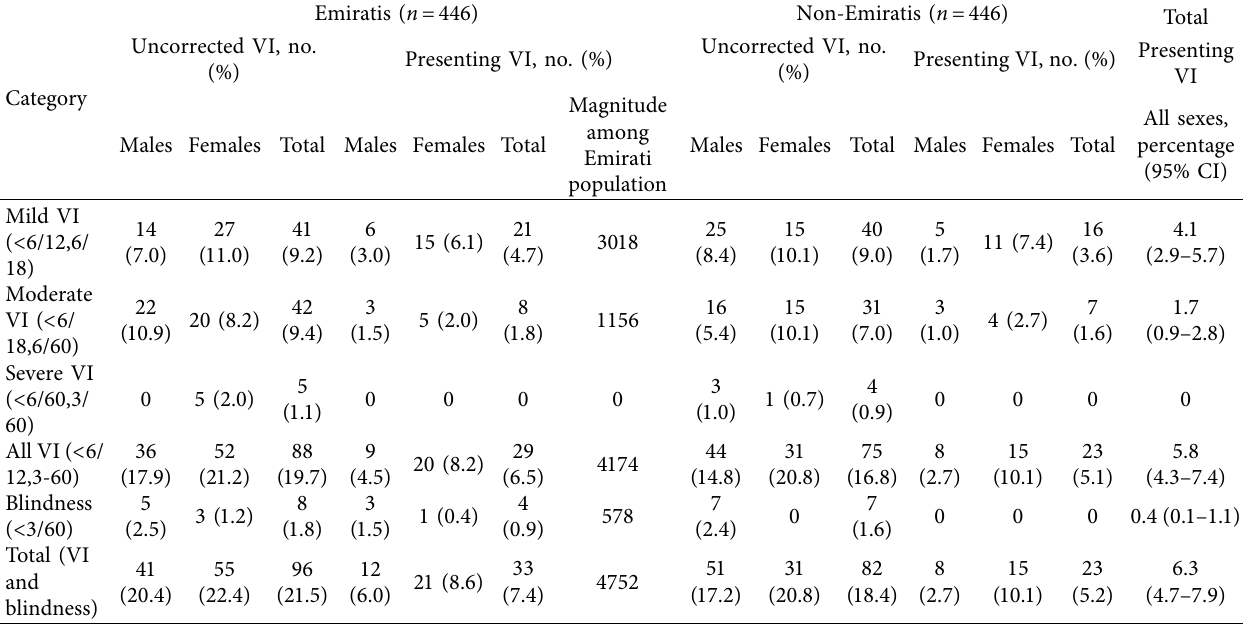
Table 2: Prevalence of uncorrected and presenting visual impairment/blindness among Emiratis and non-Emiratis by sex. Emiratis ( n � Category